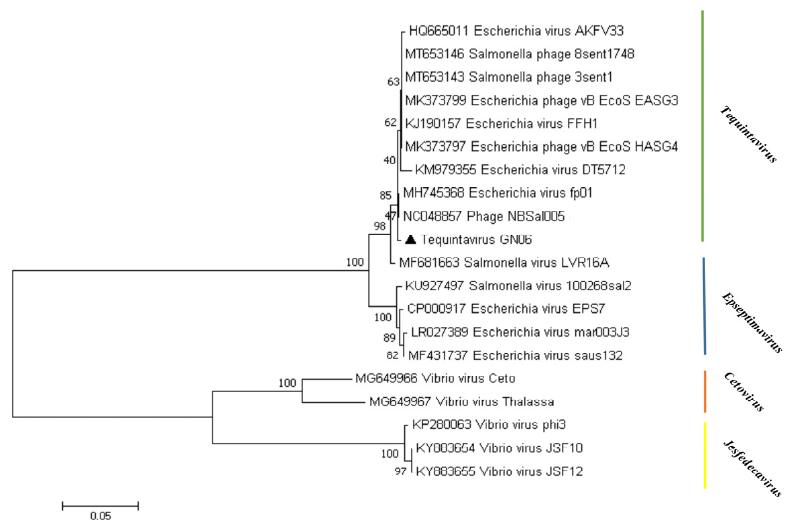
Figure 5. Phylogenetic analysis of phage vB_EcoS_GN06. The phylogenetic tree was constructed using the neighbor-joining method with 1000 bootstrap replicates. Amino acid sequences of the terminase large subunit of phage GN06 and other phages within the subfamily Markadamsvirinae were aligned in the MEGA7.